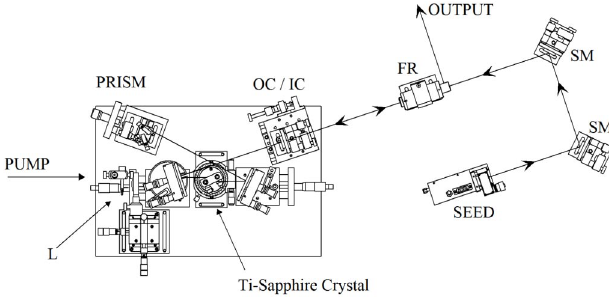
FIG. 9. The harmonic mode-locked Ti-sapphire laser: L, lens; OC/IC, output/input coupler; FR, Faraday rotator; SM, steering mirror; SEED, gain-switched diode seed laser. The Ti-sapphire laser emits rf-pulsed light (exiting after the Faraday rotator) when the seed laser pulse repetition rate is set to a multiple of the Ti-sapphire laser cavity free spectral